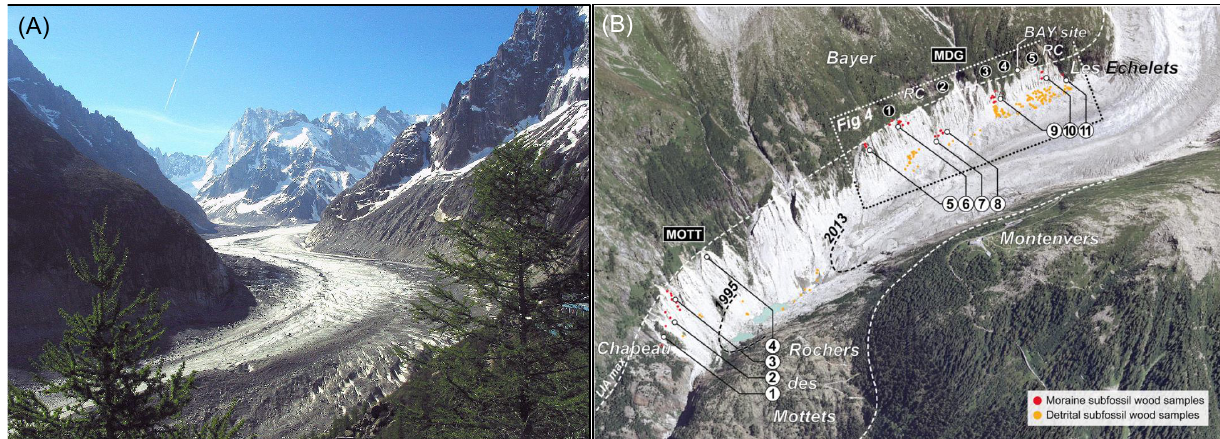
Figure 5 The lower section of the Mer de Glace glacier in the Mont Blanc mountain range, with the Grandes Jorasse (4208 m a.s.l.) in the background (A). The right figure (B) from the work of [41] shows the sampling sites at the right lateral moraine near the glacier terminus. Two positions of the terminus in 1995 and 2013, respectively, are marked with black dashed curves. For a detailed description of the sampling sites and the material recovered see Ref. [41].